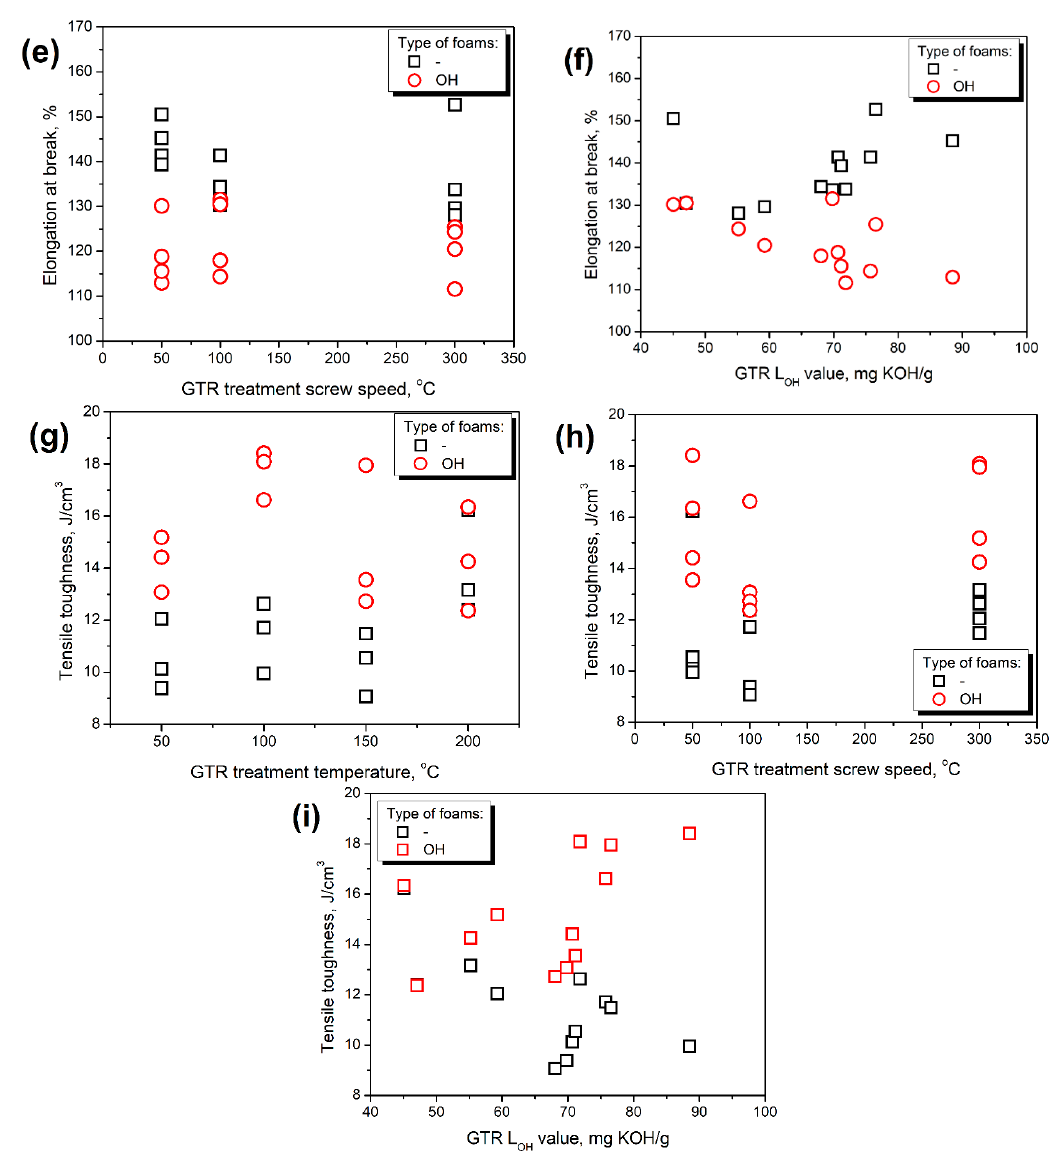
Figure 2. The impact of ( a , d , g ) GTR treatment temperature, ( b , e , h ) GTR treatment screw speed, and ( c , f , i ) GTR LOH value on the ( a , b , c ) tensile strength, ( d , e , f ) elongation at break, and ( g , h , i ) tensile toughness of prepared PU/GTR composite foams.